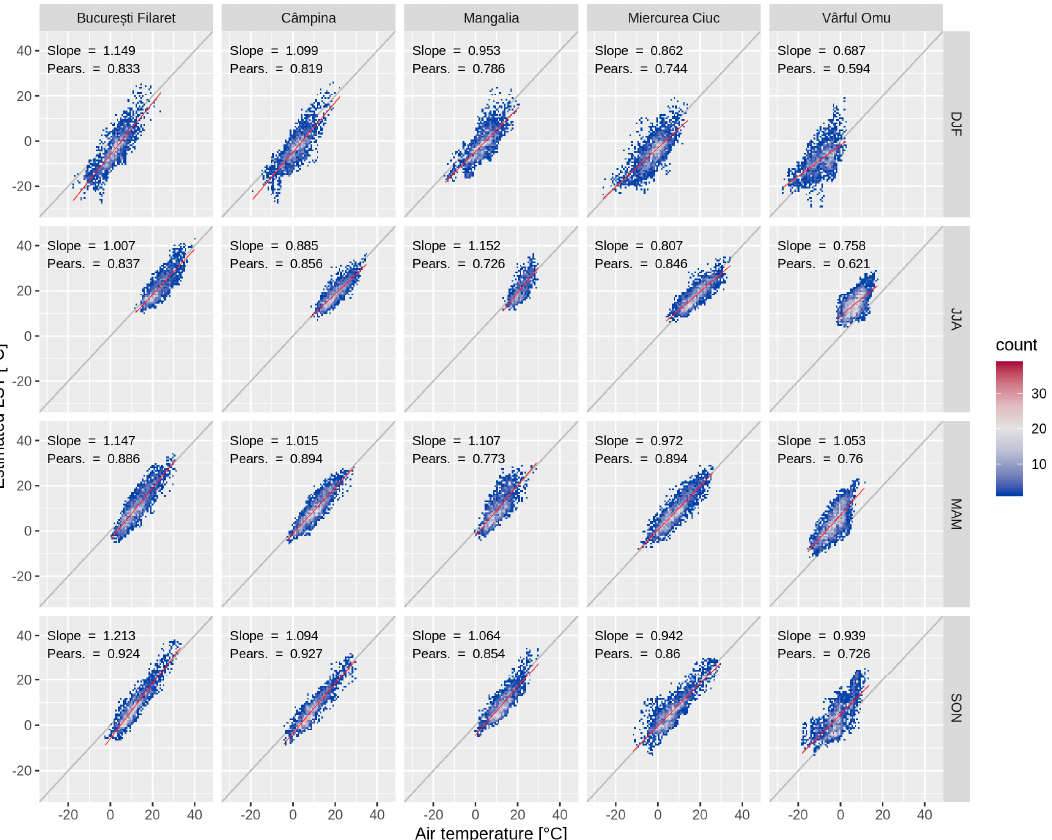
Figure 6. Seasonal scatterplots between the hourly estimated LST and hourly air temperature obtained from five meteorological stations (2016–2017). Red lines represent the best fit lines of the linear model between the two analyzed datasets, and the grey lines are the perfect fit linear models. We also compared the raw and filled monthly averages of the LST data with the air temperature aggregated on monthly scale from the weather stations (Figure 7). The reconstructed LST values is almost equal to the raw LST values and slightly lower than the air temperature in the cold season. The poor match observed especially for the cold season at Vârful Omu station is because the LST data is estimated for a very heterogeneous area covering approximately 4.5 km 2 , while the ground-based measurements are representative only for the alpine conditions of the mountain.